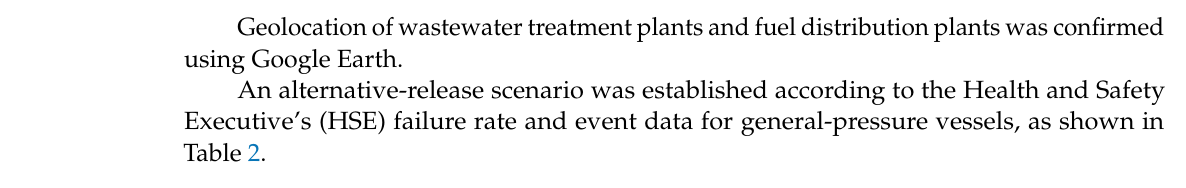
Table 2. Hazard scenarios modeled.